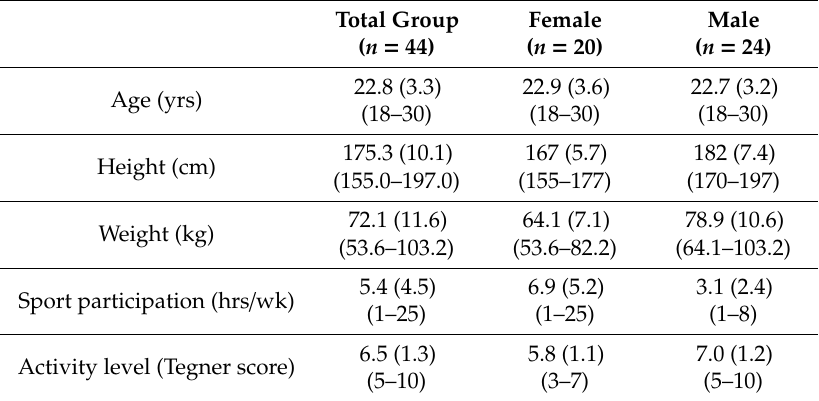
Table 1. Subject